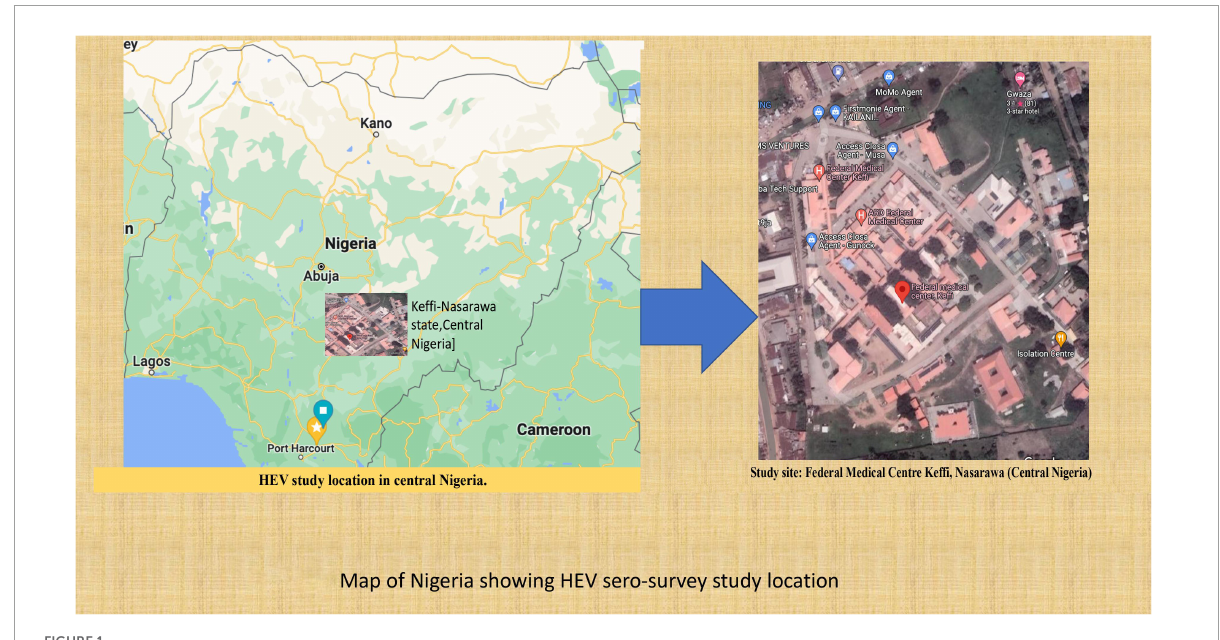
FIGURE1 Showing the HEV study site in Central